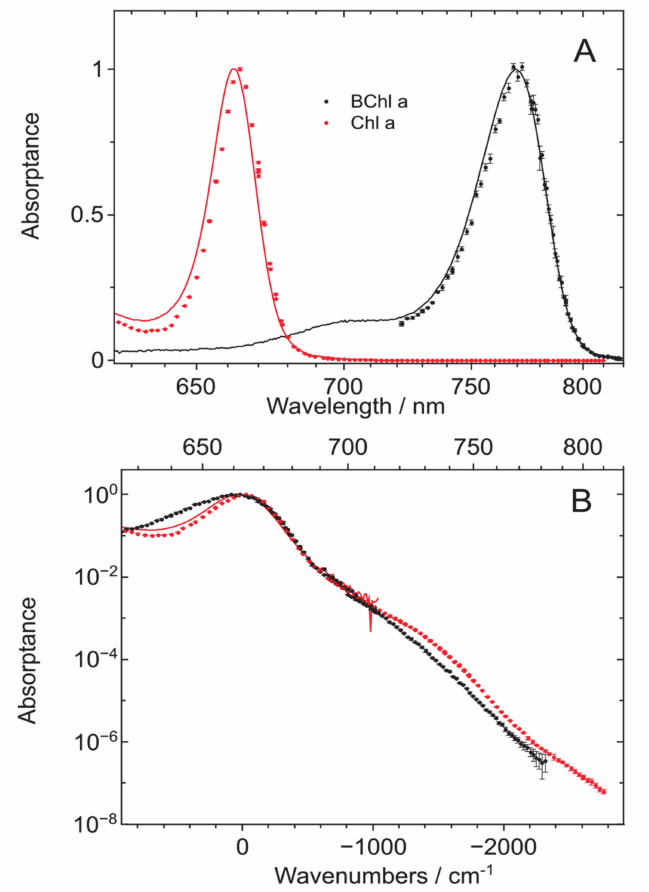
Figure 5. ( A ) Comparison of the Q y peak-normalized absorptance (solid lines) and fluorescence excitation (discrete symbols) spectra from Chl a (red) and BChl a (black, data reproduced from reference [30]) in TEA at 295 K. ( B ) The same but with BChl a spectra blue-shifted to make the Q y peaks of Chl a and BChl a coincide. Same axes as in Figures 1 and 2 are applied, except for the bottom axis of Figure 5B, which represents the frequency shift in wavenumbers relative to the Q y peak of Chl a and the corresponding blue-shifted peak of BChl a . See text for further